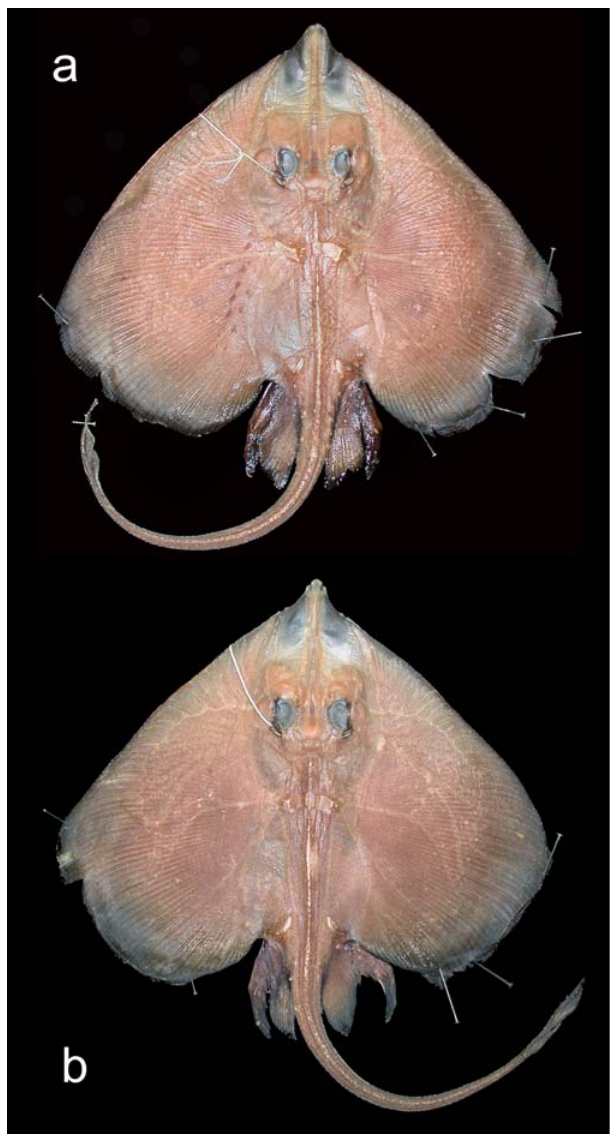
Fig. 3. Smaller male specimens of Malacoraja obscura , n. sp. (a) paratype MNRJ 28291, 355 mm TL, (b) paratype MNRJ 28292, 295 mm TL. Note dorsal lateral line canals visible through integument.